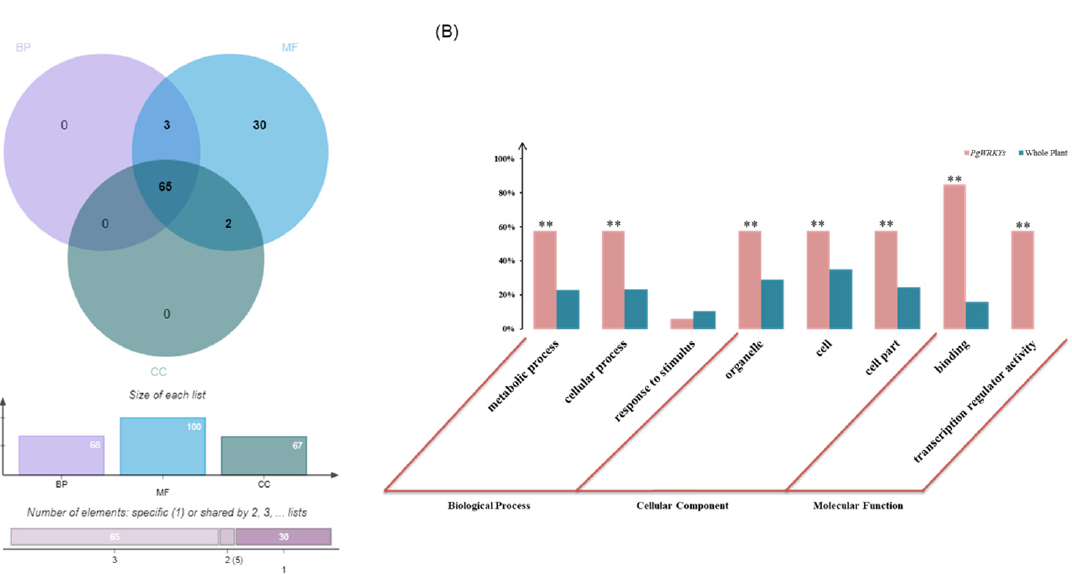
3.5. GO (Gene Ontology) Functional Categorization Analysis of PgWRKYs Of the 118 PgWRKYs , 65 (55.09%) genes were categorized into the three categories; 5 (4.24%) ( PgWRKY039-01 , PgWRKY050-10 , PgWRKY063-01 , PgWRKY038-02 , and Pg- WRKY053 ) genes had functions in two of the three categories, while 30 (25.42%) were individual, functional, and category-specific in molecular function (MF) (Figure 4A; Table S4). A further 18 (15.25) genes were missing GO function annotations.